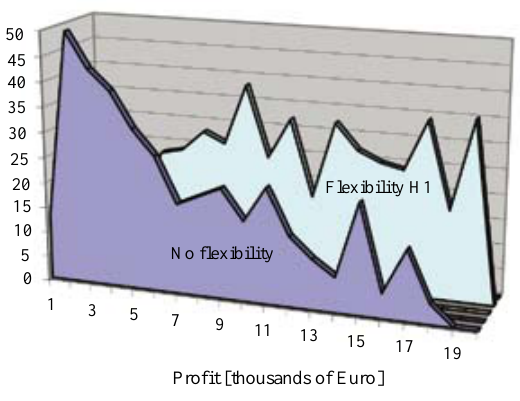
Fig. 2. Flexibility strategy effectiveness – normal scenario – runway concreting